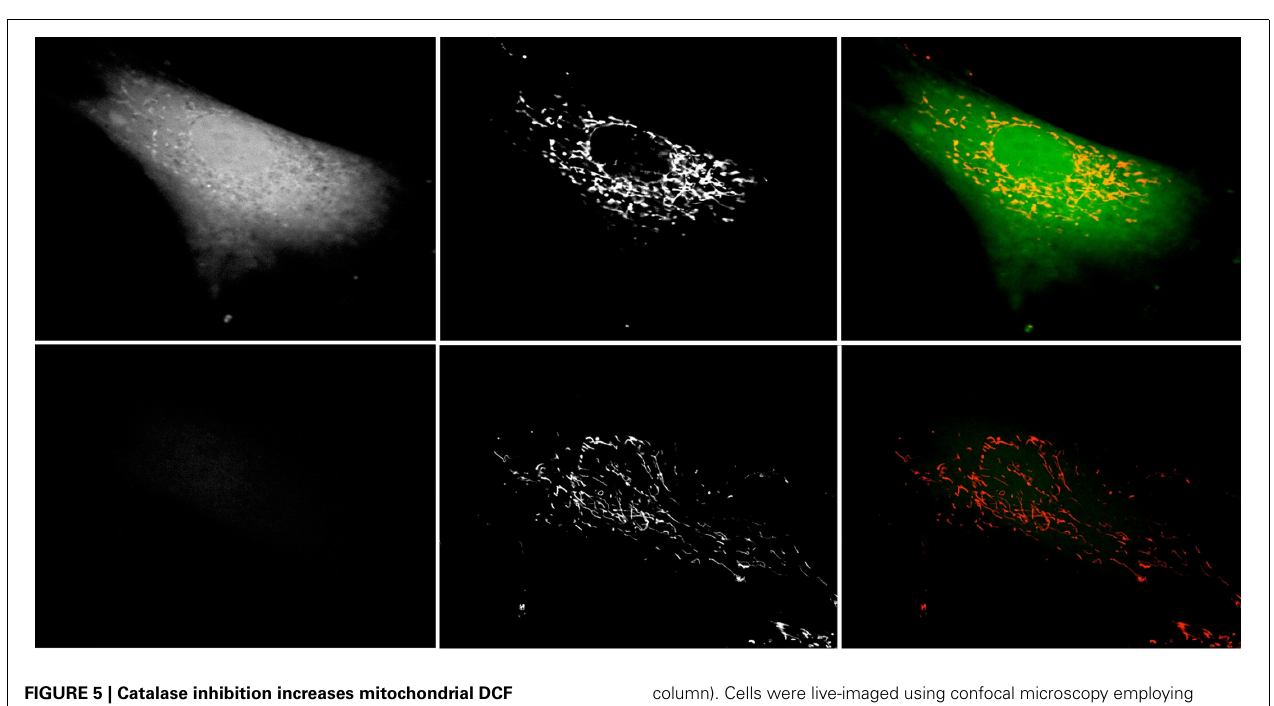
FIGURE 5 | Catalase inhibition increases mitochondrial DCF staining. Hs27 fibroblasts were grown in the presence (top row) or absence (bottom row) of 2mM 3-AT for 48h, after which they were treated with the ROS-sensitive dye 2,7-DCF (left column) and the mitochondrial ROS-sensitive dye MitoTracker Red CM-H2XRos (center